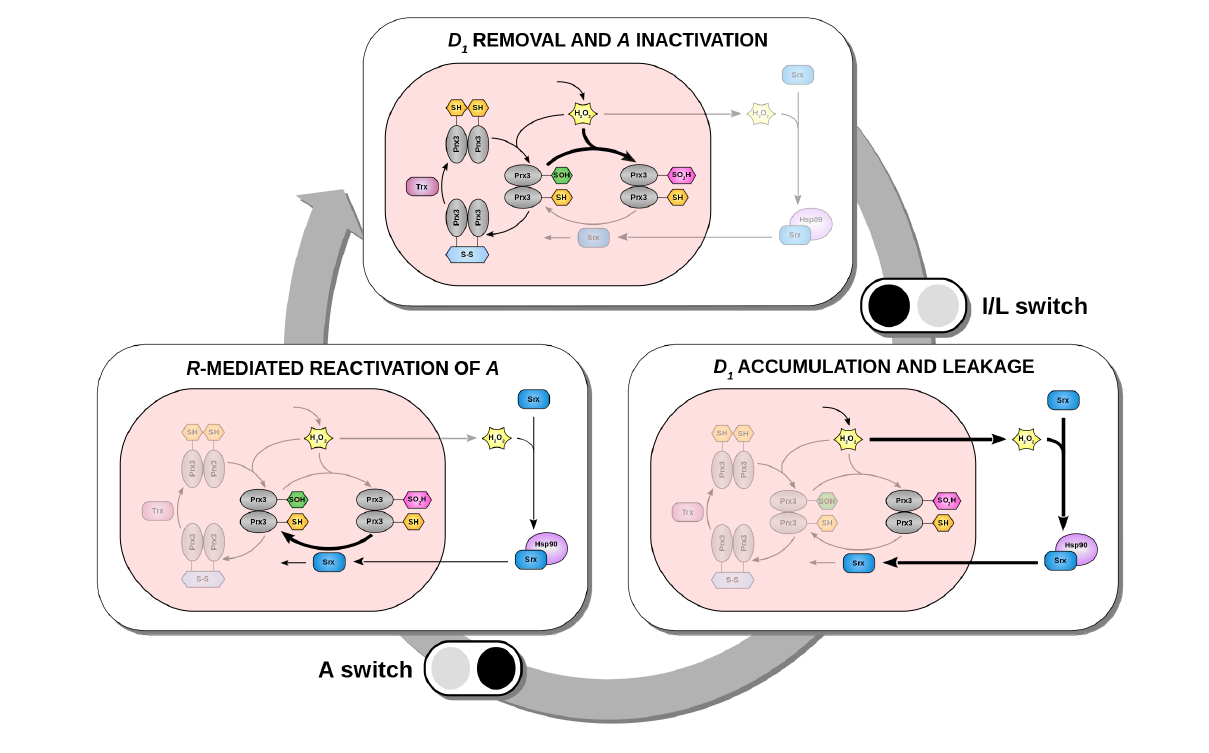
Figure 6. Model for the mechanism underlying circadian oscillations of Prx3-SO 2 H and Srx in mitochondria of mammalian adrenal gland, heart, and brown adipose tissue. Three phases and two temporal switches conceptually explain the generation of oscillations. The switches are represented by the black/gray icons. The switch occurs from black to gray: the black circle represents the phase from which the system comes, and the gray circle depicts the phase it progresses